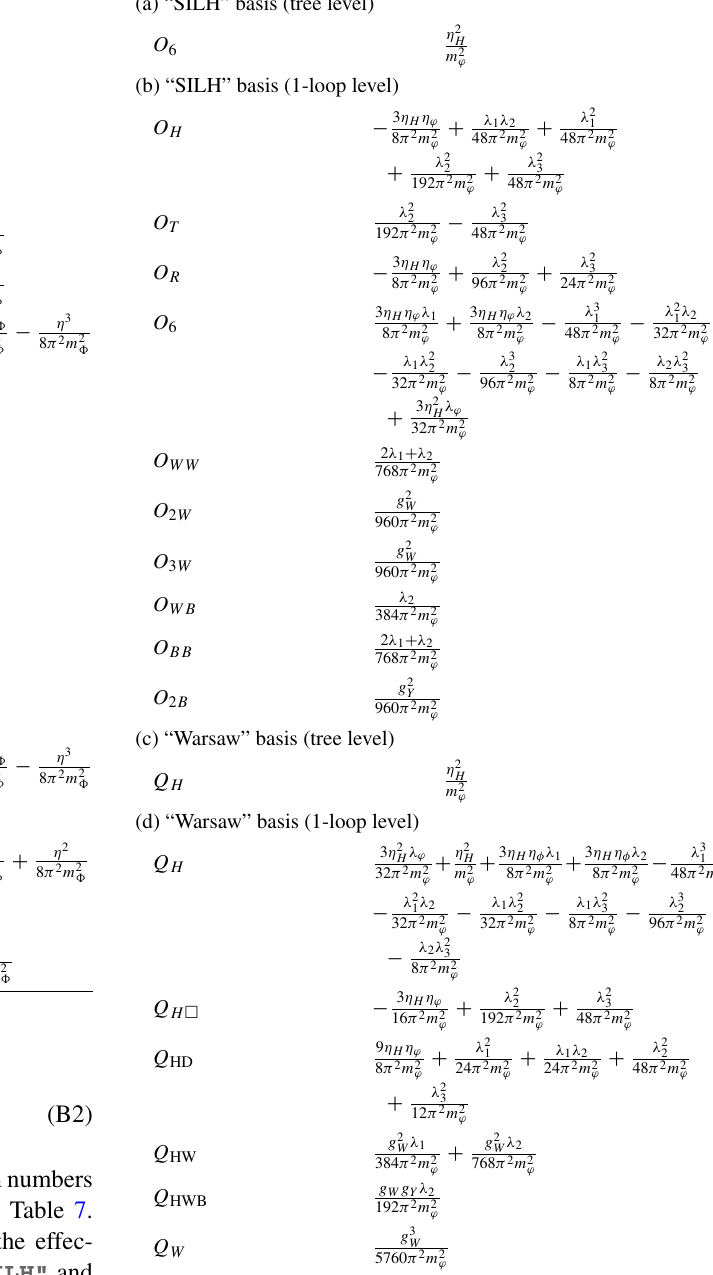
Table 8 Effective operators and Wilson coefficients in for the real triplet scalar (Y=0) model. As the light–heavy mixing (which can be ignored safely for phenomenological analyses) is not included, this result is incomplete Dimension-6 operators Wilson coefficient